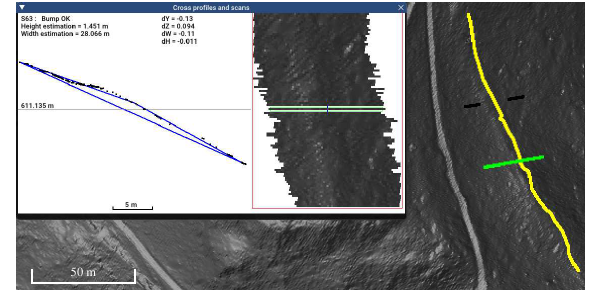
Figure 8. Detected layout of STR 2